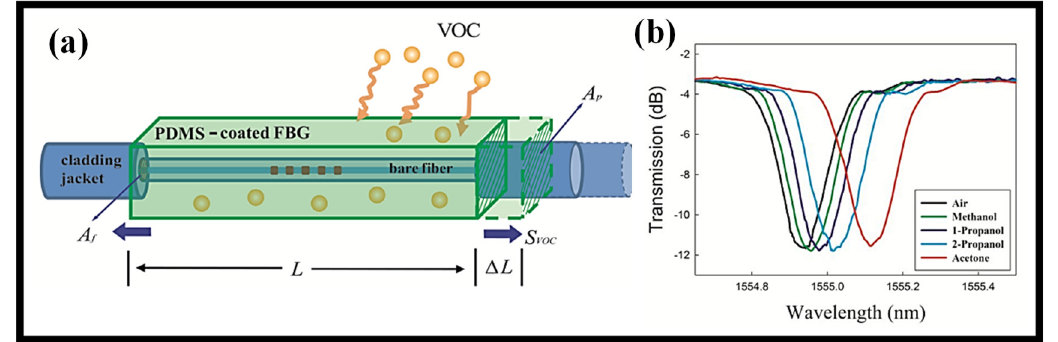
Figure 9. ( a ) PDMS-coated FBG sensor schematic diagram [135], ( b ) sensor spectral response for each VOC